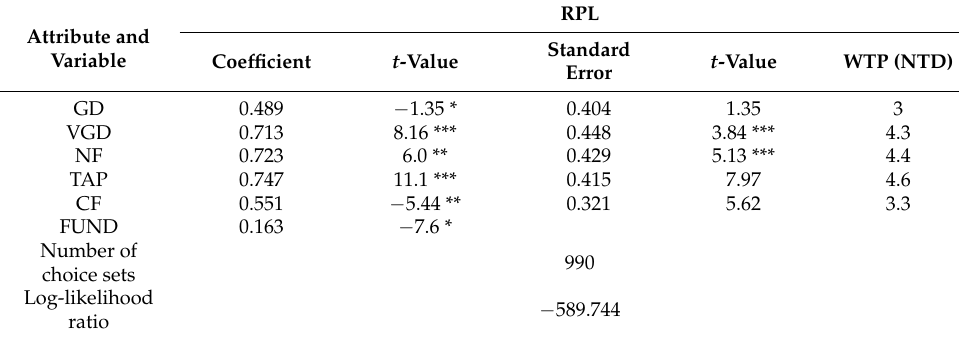
Table 3. Estimation results of the RPL